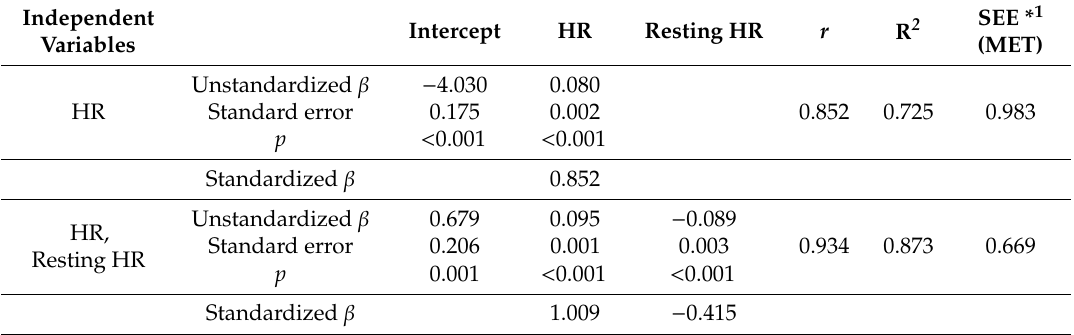
Table 4. Results of multiple regression analyses for estimating METs; model with HR (n = 40).